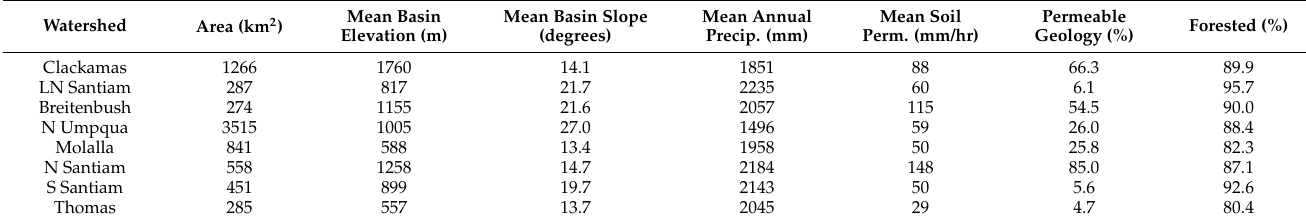
Table 1. Oregon watershed characteristics obtained from USGS StreamStats web tool [55].